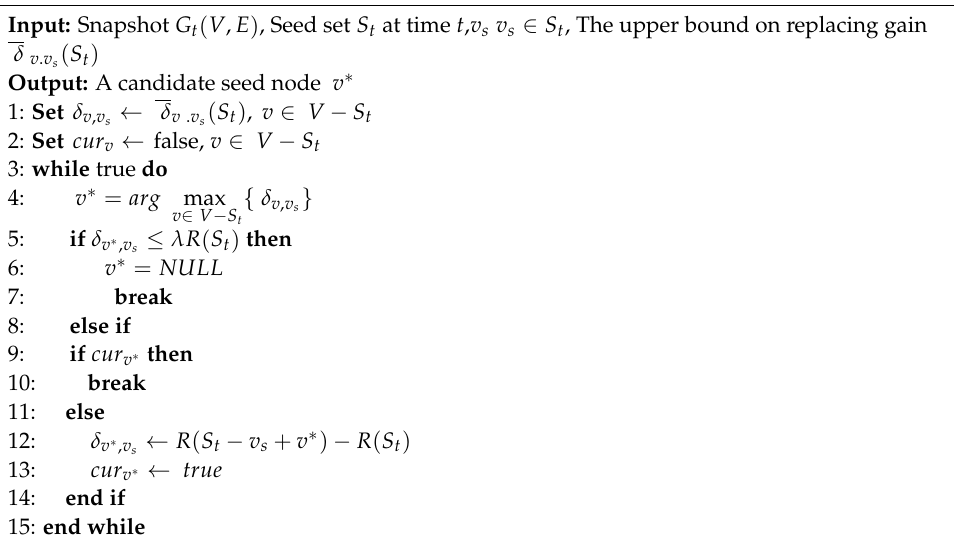
Algorithm 2 Select a candidate seed